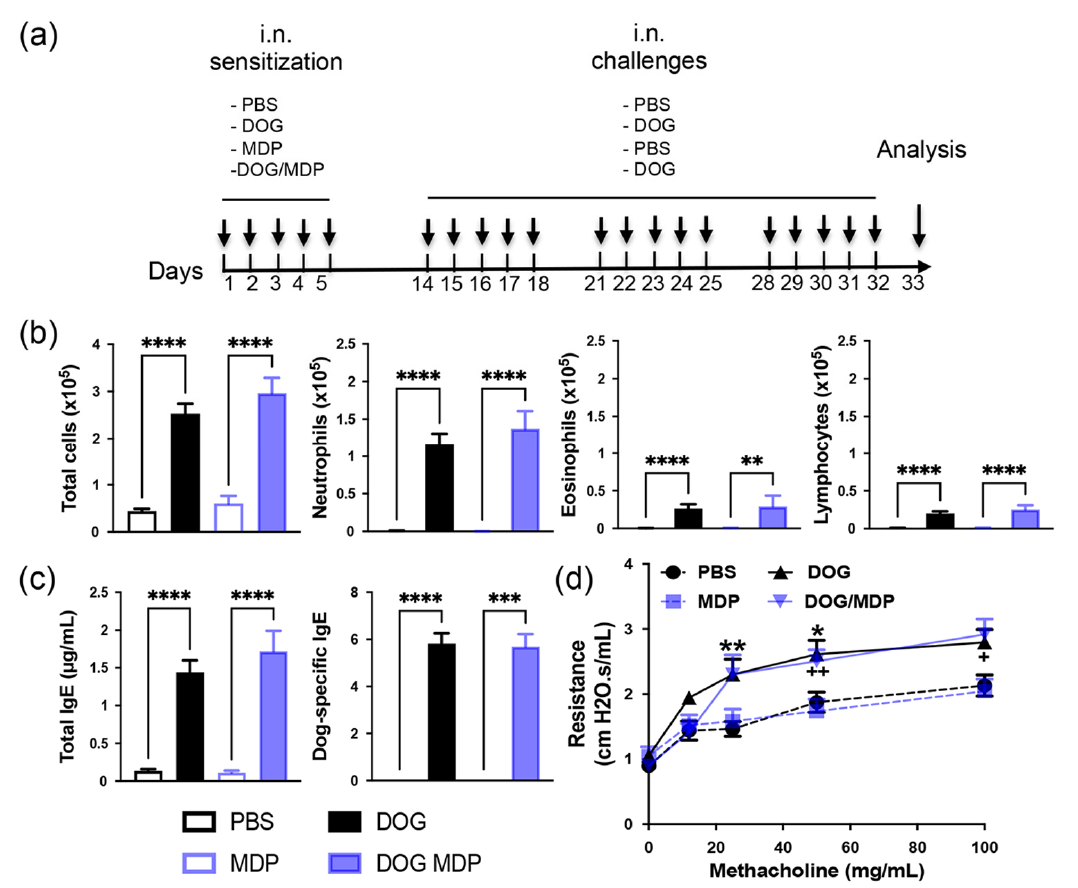
Figure 1. NOD2 ligand co-administration does not aggravate allergen-induced airway cell recruitment, humoral response, and AHR. ( a ) Protocol of dog-induced experimental AAI, with or without NOD2 agonist co-administration. ( b ) BAL cell counts in control (PBS and MDP) and challenged (dog and dog/MDP) mice. ( c ) ELISA measurement of total IgE and dog-specific IgE (as titers) in sera. ( d ) AHR in control and challenged mice. Data are presented as mean ± SEM (n = 7–22 mice per group, or n = 5–11 mice per group for AHR). * p < 0.05, ** p < 0.01, *** p < 0.001, **** p < 0.0001 versus PBS or indicated column; + p < 0.05, ++ p < 0.01 versus MDP. Kruskal–Wallis test for all, except AHR, which is 2-way